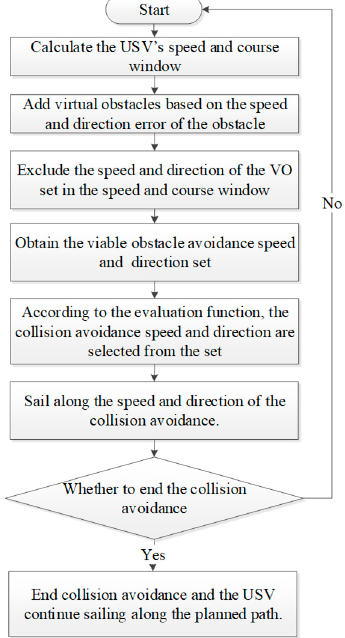
Figure 9. The flowchart of the short-range real-time collision avoidance algorithm.